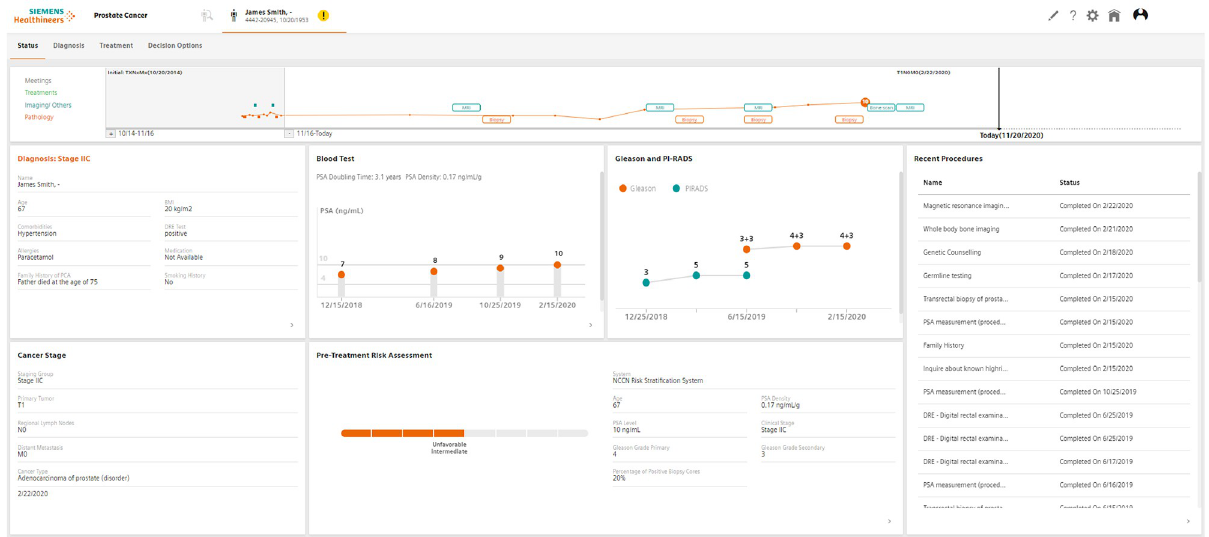
Fig 1. AIPC status page: Aggregates and correlates data from patient longitudinal history, imaging and pathology reports, laboratory results, and clinical studies. Displays a patient’s historical timeline summary of relevant clinical events. Provides historical trends and progression of key